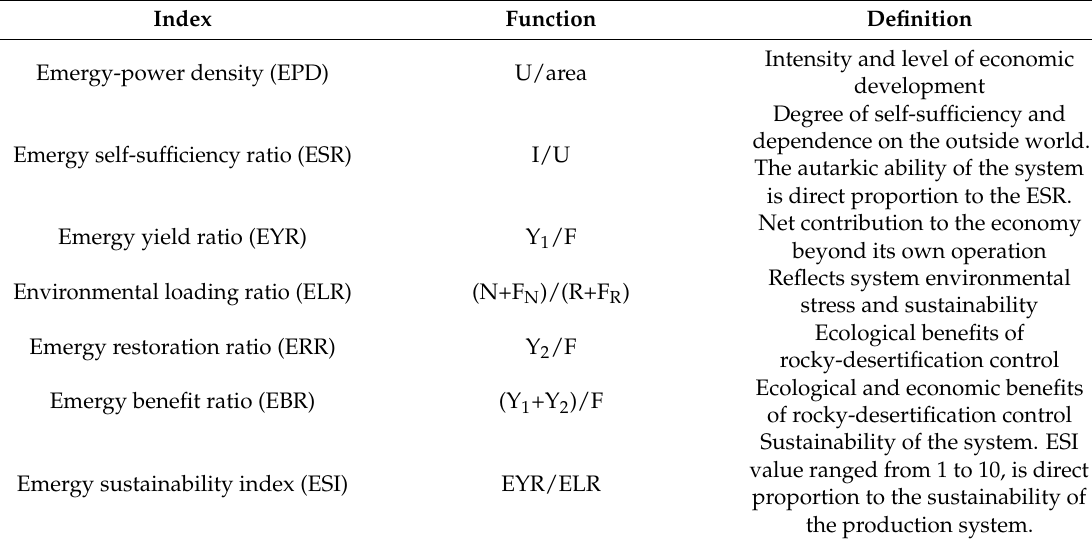
Table 2. Emergy evaluation indices in this